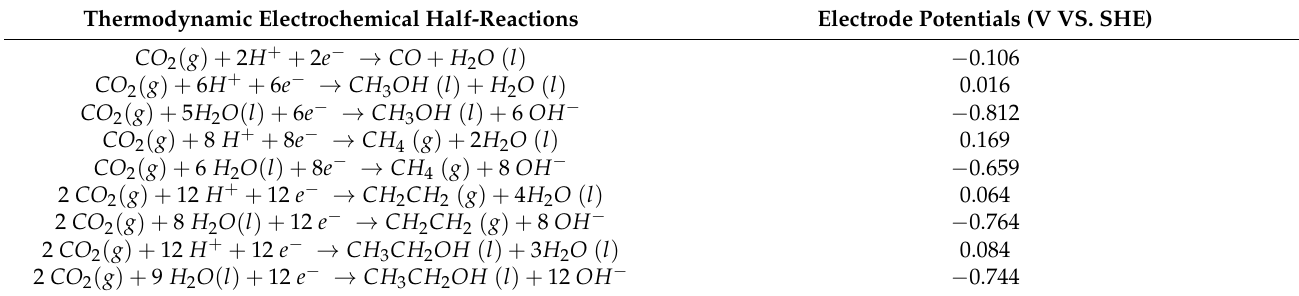
Table 19. Half-cell reaction pathways for carbon dioxide electroreduction and respective thermodynamic potentials (V vs. SHE; i.e., electrode potentials vs. “standard hydrogen electrode”) for reactions performed in aqueous solution, at 298 K and 1.0 atm. Reproduced with permission from Jinli Qiao, Yuyu Liu, Feng Hong, Jiujun Zhang, Chemical Society Reviews; published by Royal Society of Chemistry, 2014 [483]. Thermodynamic Electrochemical Half-Reactions Electrode Potentials (V VS. SHE)